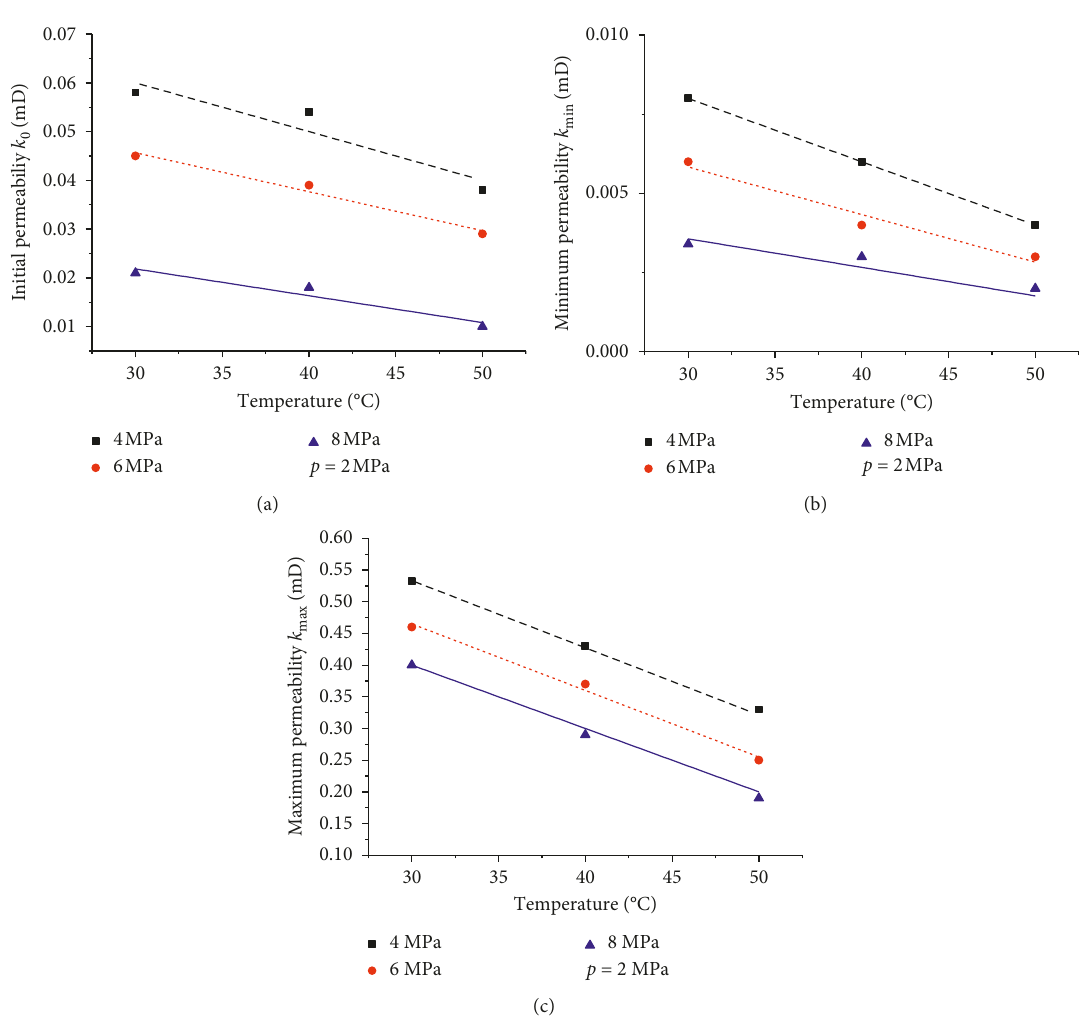
Figure 8: Relationships between (a) initial, (b) minimum, and (c) maximum permeability and temperature at different confining pressures.